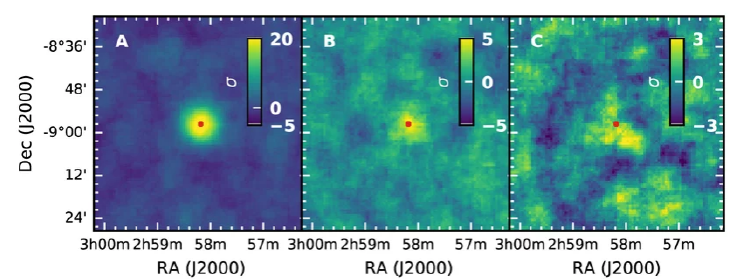
Figure 10. The H.E.S.S. sky map centered at the coordinates of GRB 190829A. The VHE signal was clearly detected for three consecutive nights up to T 0 + 51 h. Reprinted with permission from Ref.